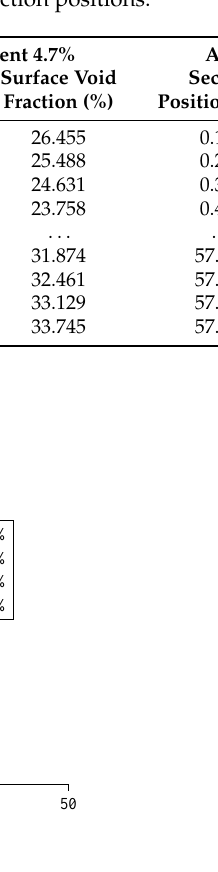
Table 5. EPA-13 surface voids at different vertical section positions.